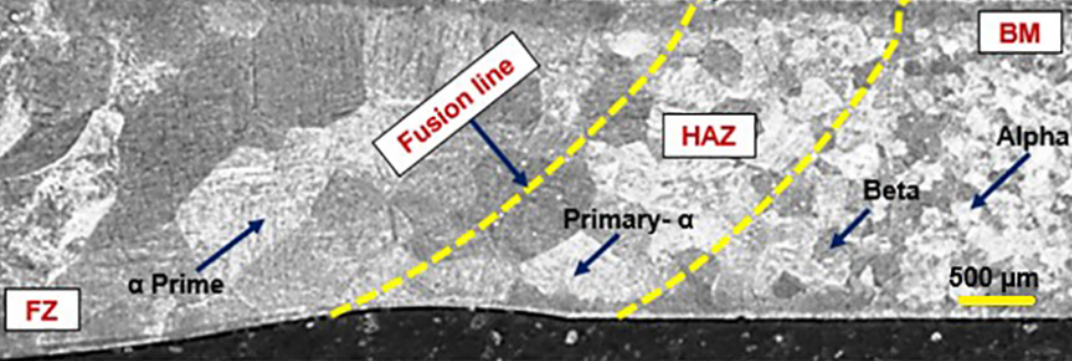
Figure 8. Microstructure of BM, HAZ and Fusion